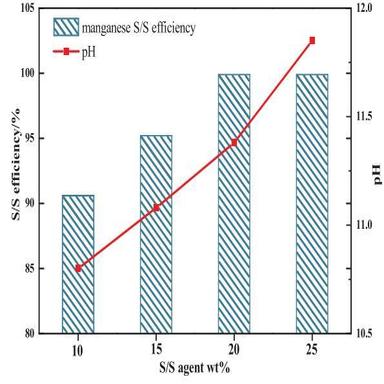
Change of pH and solidification rate of manganese at the different dose of S/S agent.